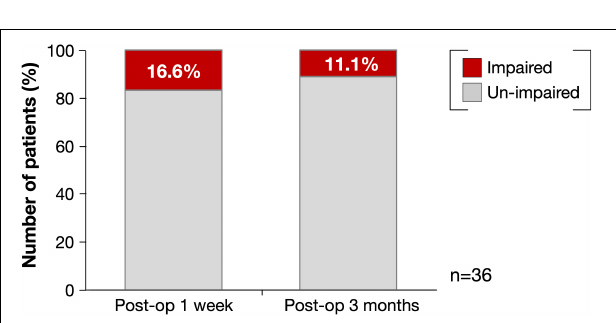
FIGURE 3 | Percentage of deficit for selective attention at postoperative 1 week and 3 months. Red, impaired patients (Z ≤ − 1.65); Light gray, un-impaired